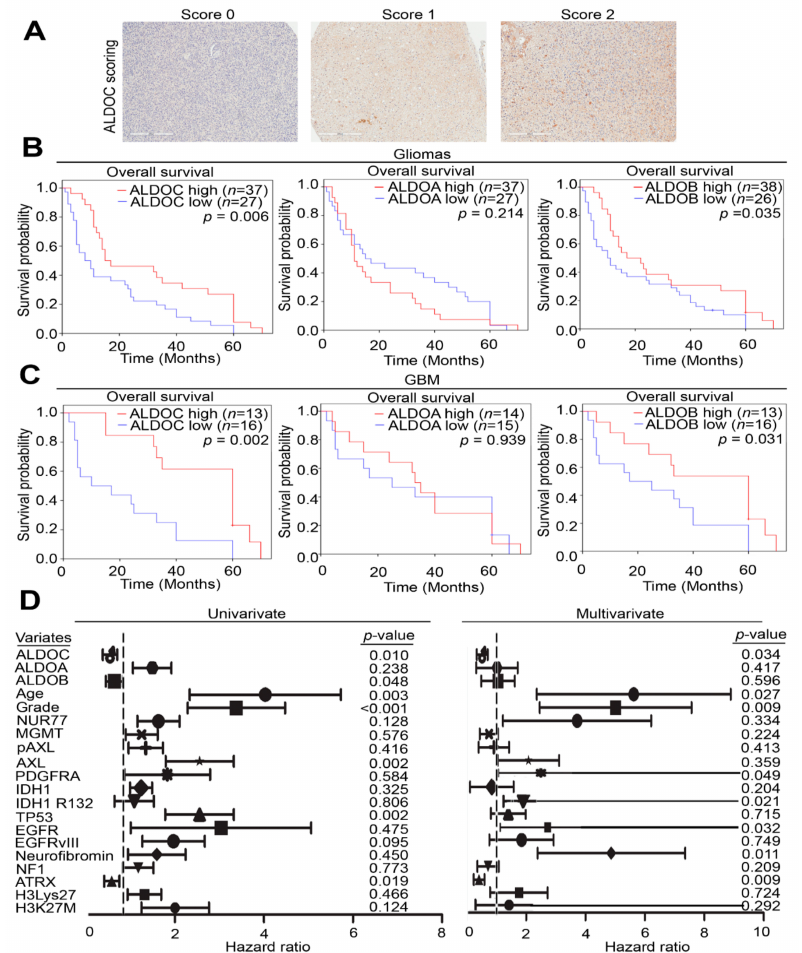
Figure 6. ALDOC protein level as independent prognostic factor in glioblastoma patients. ( A ) The scores (0–2) indicate ALDOC protein level by immunohistochemistry in representative brain tumor tissues. ( B ) Kaplan–Meier analysis of ALDOA, ALDOB, and ALDOC alone at concurrently low or high levels as determined by IHC staining at the endpoint of overall survival probability and disease-free survival probability in brain cancer patients, respectively. ( C ) Kaplan–Meier analysis of ALDOA, ALDOB, and ALDOC alone at concurrently low or high levels as determined by IHC staining at the endpoint of overall survival probability and disease-free survival probability in glioblastoma patients, respectively. ( D ) Multivariate analysis and univariate analysis of ALDOA / ALDOB / ALDOC and clinical parameters in the clinical cohort. The significance of the di ff erences in B and C was analyzed using a Cox progression. All cut-o ff values were set before analysis, and all tests were two-tailed. informed